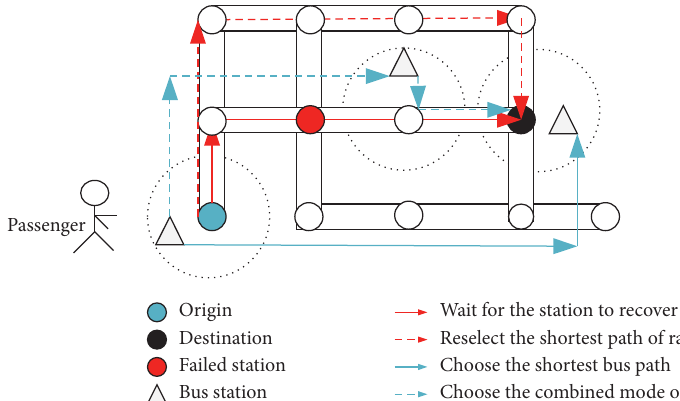
Figure 2: Travel schemes of